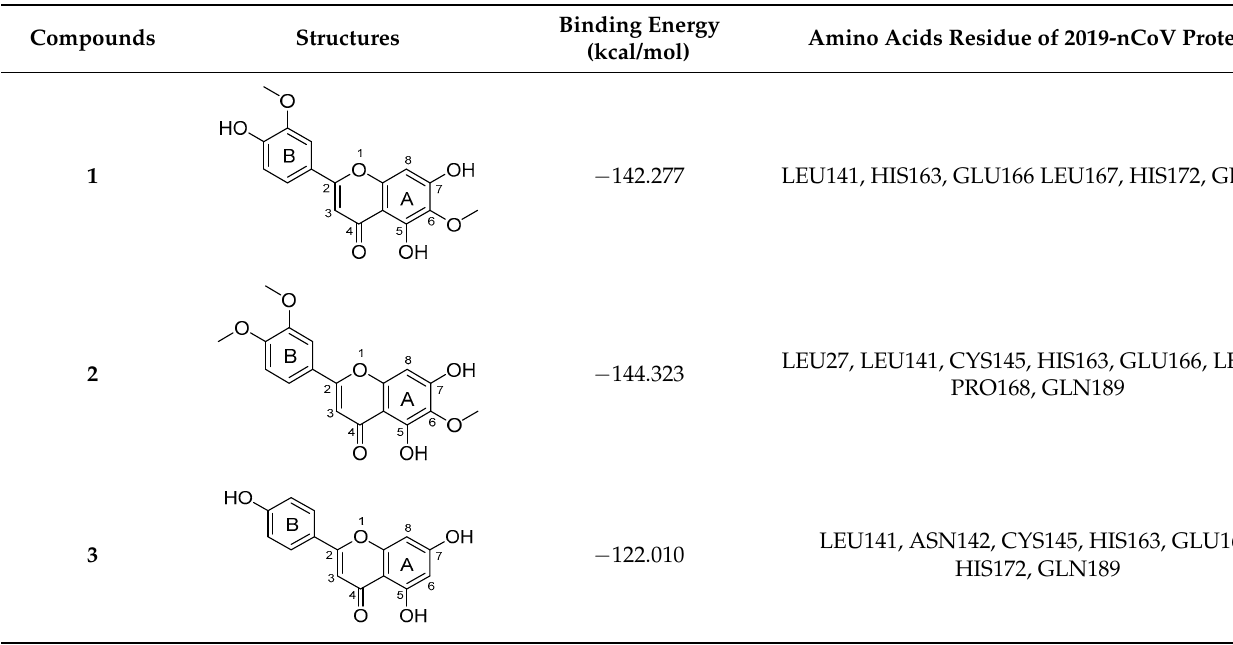
Figure 3. ( a ). The electrostatic surface potentials of compounds 1 – 6 and dihedral angels of hydroxy group in chromone. ( b ). The illustration of electron repulsion. Table 2. Data analysis of the flexible docking of compounds 1 – 6 in the active site of the 2019-nCoV protease